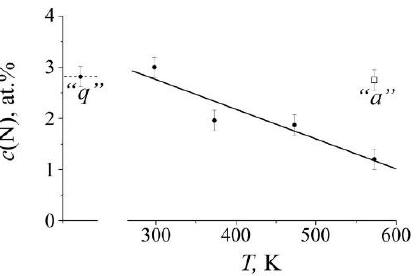
Figure 6. The dependence of the nitrogen content c (N) in the austenite matrix on the deformation temperature of the HPT of the quenched steel. The point “ q ” indicates the nitrogen content in the initial quenched steel. The point “ a ” indicates the nitrogen content after HPT of n = 3 at 298 K, for 30 min and subsequent annealing at 573 K, for 30 min.